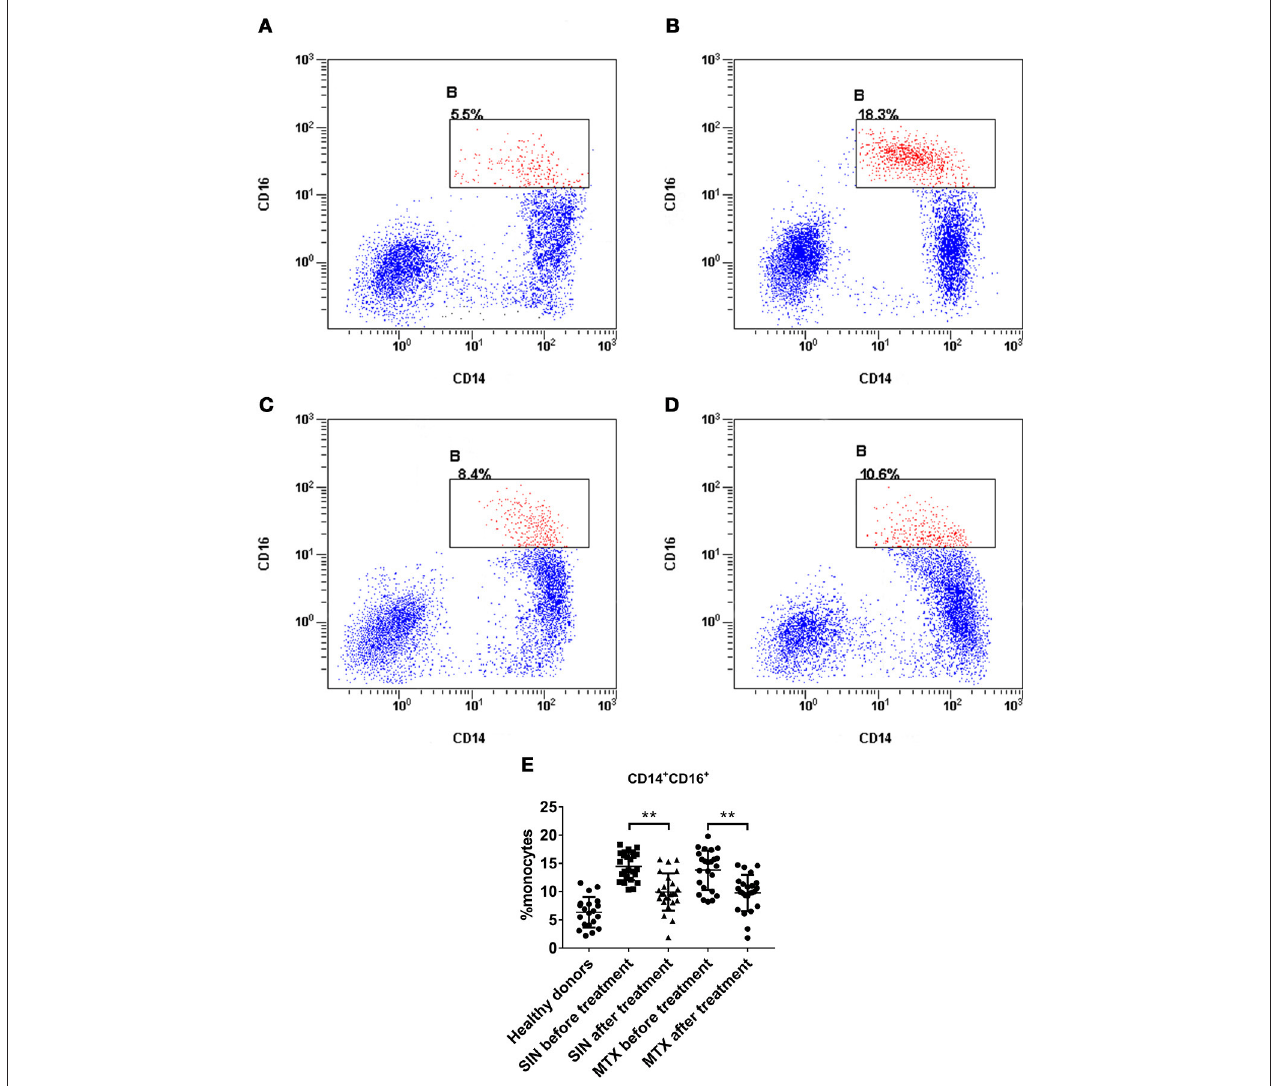
FIGURE 9 | SIN reduced the percentage of CD14 + CD16 + monocytes in RA patient PBMCs. A representative flow cytometry analysis of CD14 + CD16 + percentage in PBMCs of (A) heathy donors (B) patient with active RA (C) after SIN treatment RA patient (D) after MTX treatment RA patient. (E) Analysis of the percentage of CD14 + CD16 + monocytes in PBMCs of each group. Heathy donors, n = 20, SIN before treatment, n = 25, SIN after treatment, n = 25, MTX before treatment, n = 24, MTX after treatment, n = 24. Each dot represents one sample. Significance was analyzed by unpaired two-sided t -test. ** P <